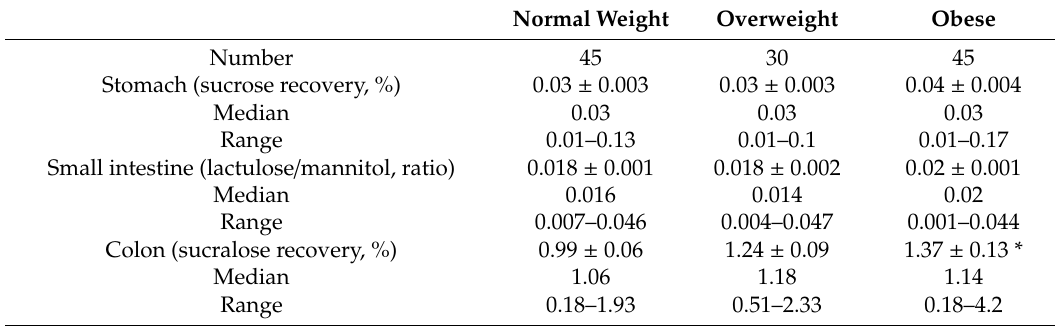
Table 2. Intestinal permeability at different gastrointestinal tracts, according to BMI. Normal Overweight Obese Weight